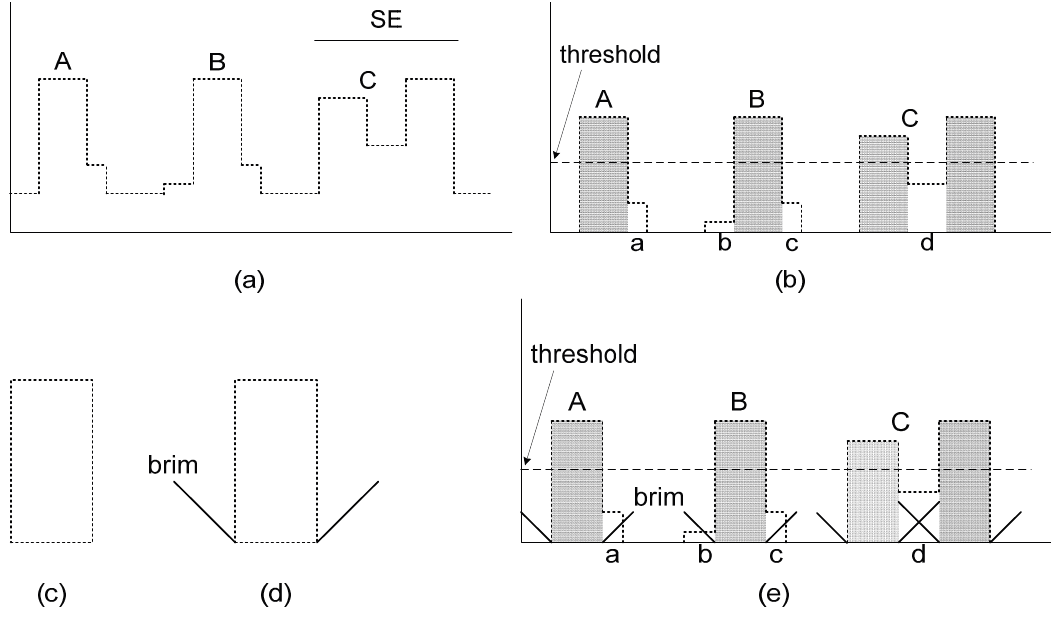
Figure 2. Example of the improved top-hat filter with a sloped brim for identifying complex objects with multilayer structures: ( a ) original point set; ( b ) results by top-hat transformation (gray portions represent the parts extracted by thresholding the top hats); ( c ) shape of classic top-hat filter; ( d ) shape of improved top-hat filter with sloped brim; ( e ) suspicious parts inspected by improved top-hat filter.